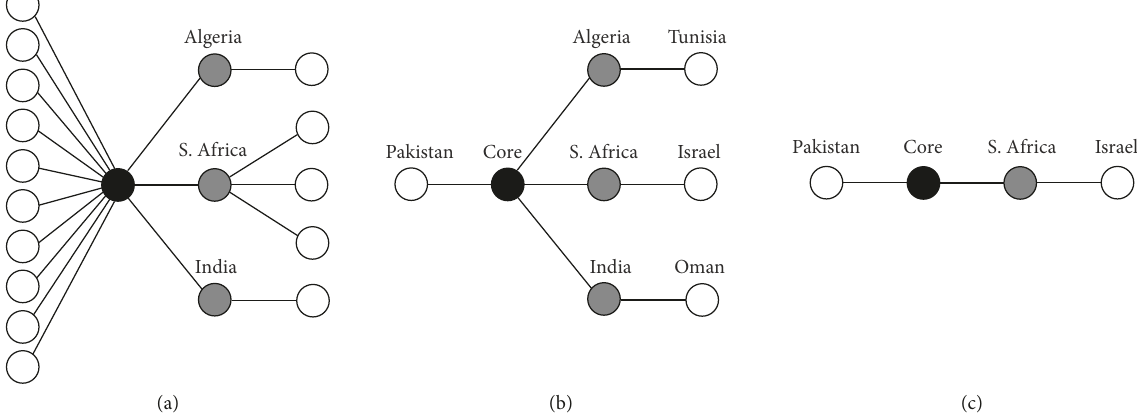
Figure 5: Clustering with threshold 75 M USD: (a) CSP network; (b) reduction of false twin vertices; (c) CSP structure.